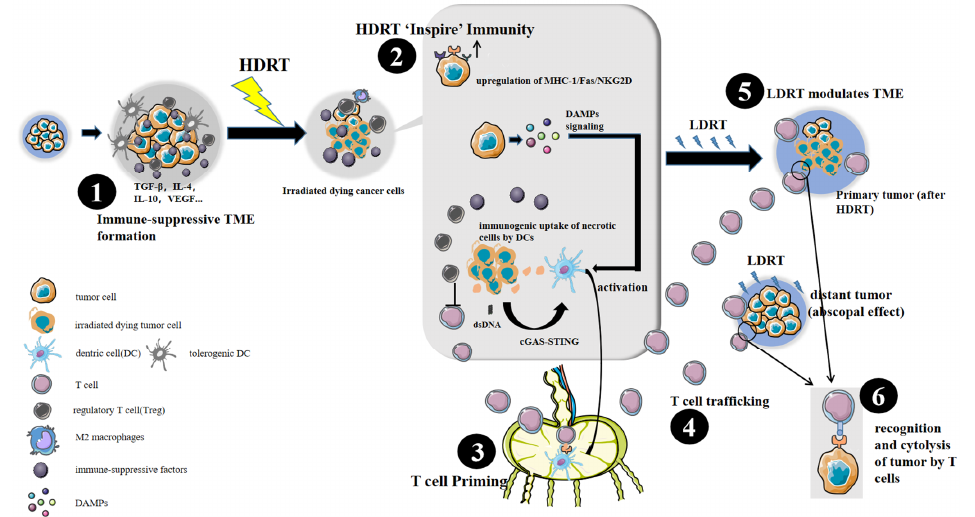
Figure 1. A hypothesis-based immune response model. In the course of tumor growth, the tumor microenvironment (TME) accumulates high concentrations of immune-suppressive cytokines/growth factors, such as transforming growth factor beta (TGFβ) and vascular endothelial growth factor. Under their action, immunosuppressive cells (black cells), regulatory T-cells, and myeloid cells, will prevail in the tumor environment. Dentric cells (DCs) become tolerogenic and immune effector cells cannot infiltrate the tumor ( 1 ). After high-dose irradiation ( 2 ), many immune pathways are activated. Firstly, high-dose radiotherapy (HDRT) will cause tumor cell necrosis and the release of tumor cell debris, which can be taken up by antigen-presenting cells (APCs). Secondly, HDRT causes dsDNA release, triggering the cGAS-STING-IFN-1 pathway. In addition, HDRT up- regulates cell surface molecules such as MHC-1/Fas/NKG2D. Activated APCs then migrate to the lymph nodes, where they educate and prime cytotoxic T-cells ( 3 ). Cytotoxic T-cells will enter the bloodstream ( 4 ) to reach primary and distant tumor sites and kill tumor cells. However, these effec- tor immune cells might not be able to enter primary or distant tumor stroma because of immune- suppressive barriers that are formed naturally or after HDRT. Low-dose radiotherapy (LDRT) en- hances immune cells infiltration and diminishes immune-suppressive cells and cytokines, acting in